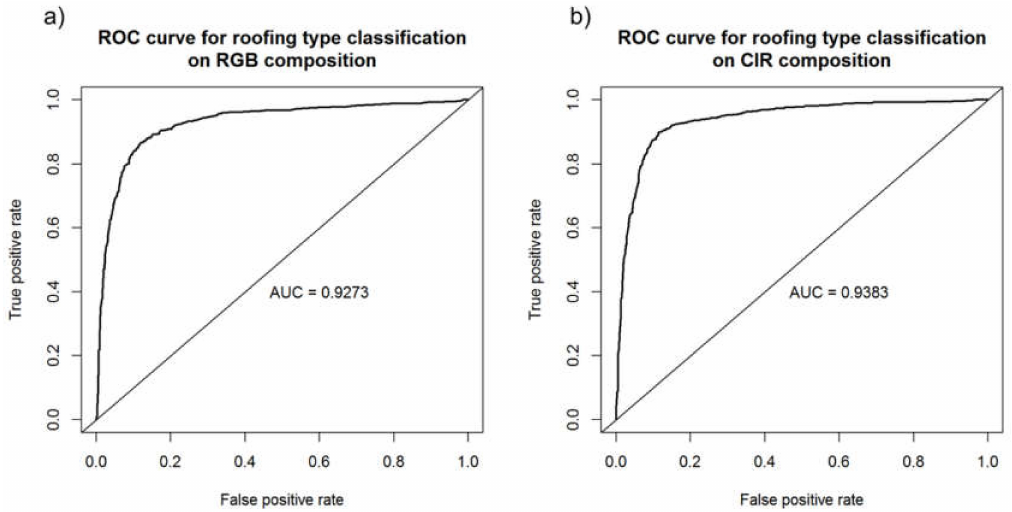
Figure 6. ROC curves for roofing type classification: ( a ) RGB; ( b ) CIR.